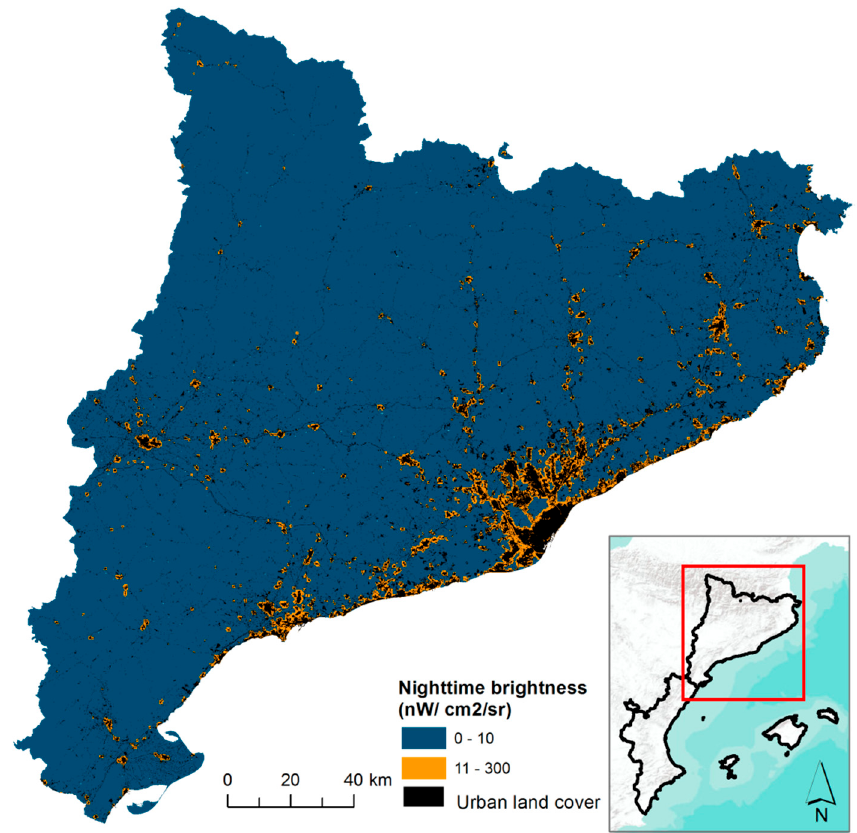
Figure 3. Light level (nW/cm 2 /sr) 2012 and urban land cover in Catalonia (Centre de Recerca Ecològica i Aplicacions Forestals (CREAF)) 2009.